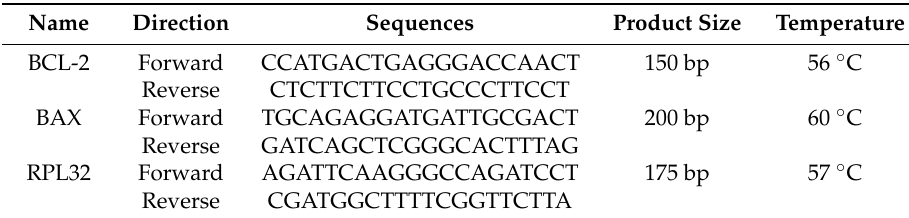
Table 1. Primers used for gene expression